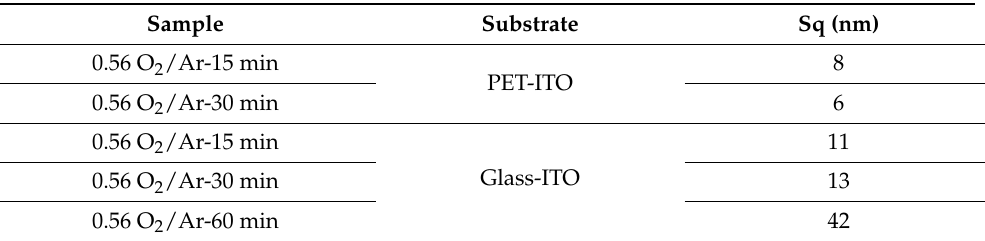
Figure 8. X-ray reflectivity (XRR) spectra and simulations of the film’s growth at the 0.56 O 2 /Ar flow rate during ( a ) 60, ( b ) 30 and ( c ) 15 min. Table 4. Surface roughness (root mean square height, Sq) measured by optical profilometry of the samples grown at flow rate of 0.56 O 2 /Ar with different deposition